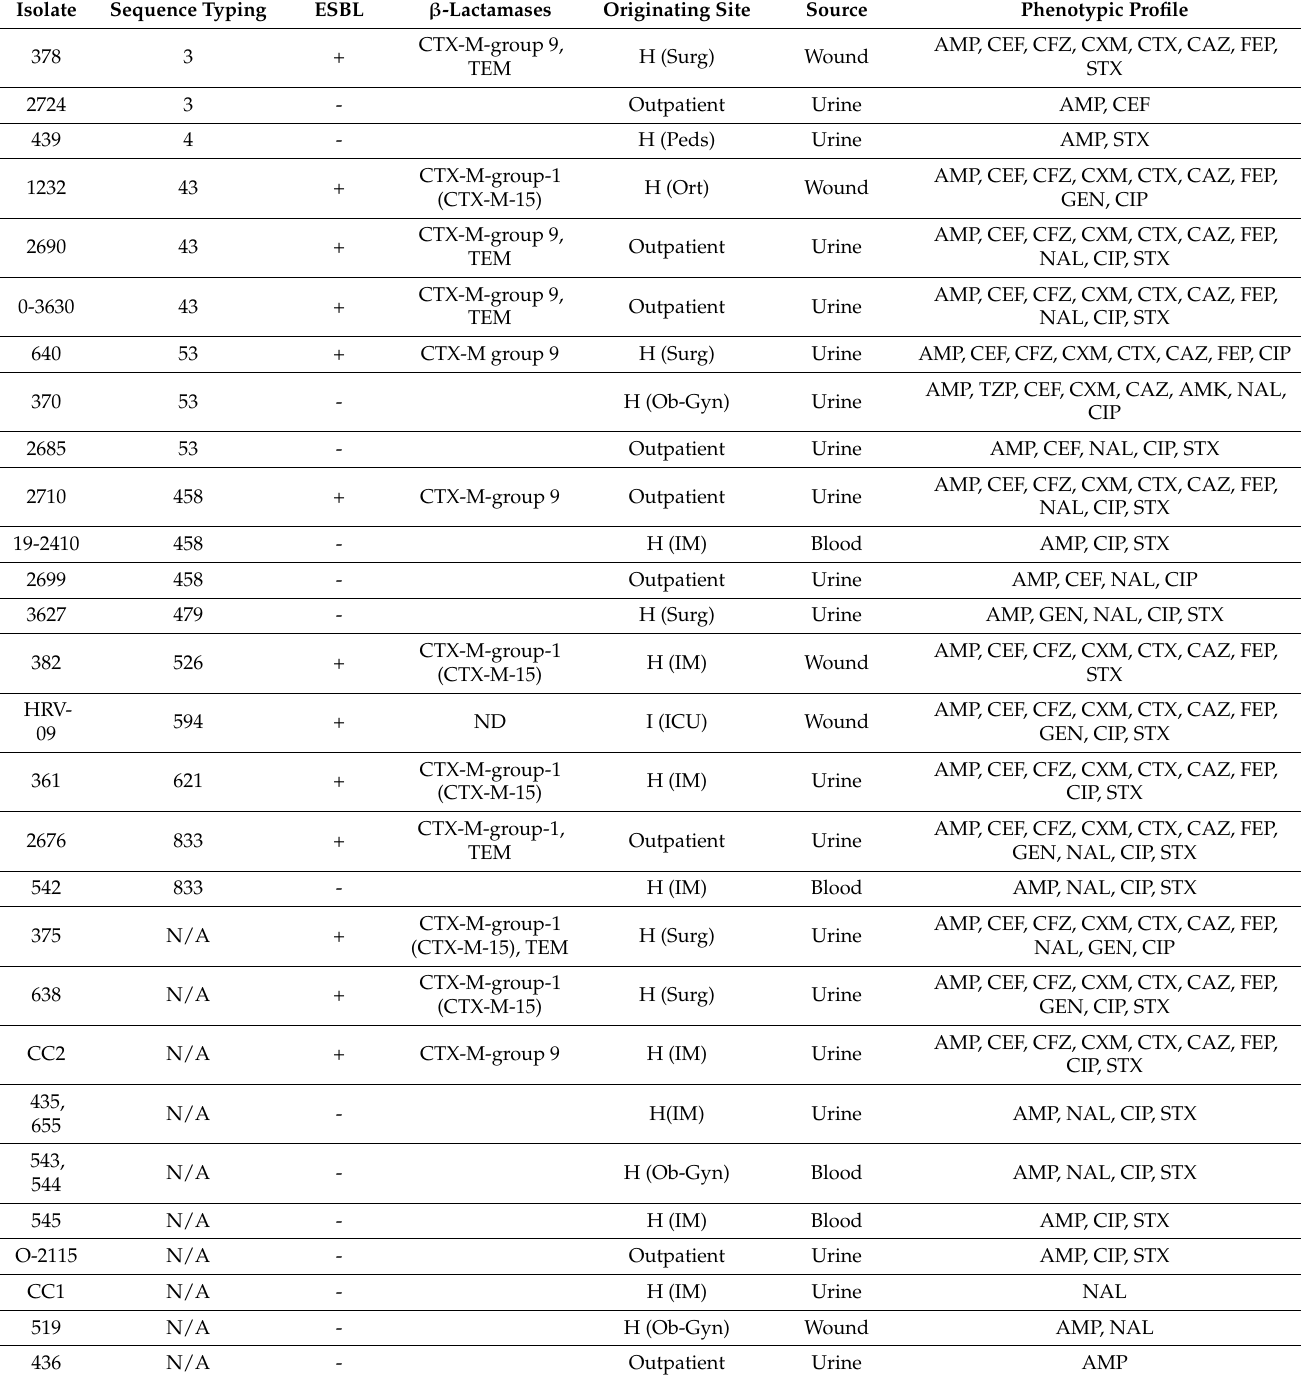
Table 3. Phenotypic and genotypic characteristics of Escherichia coli